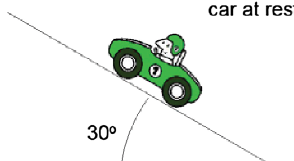
FIG. 1. Friction problem used in the study.